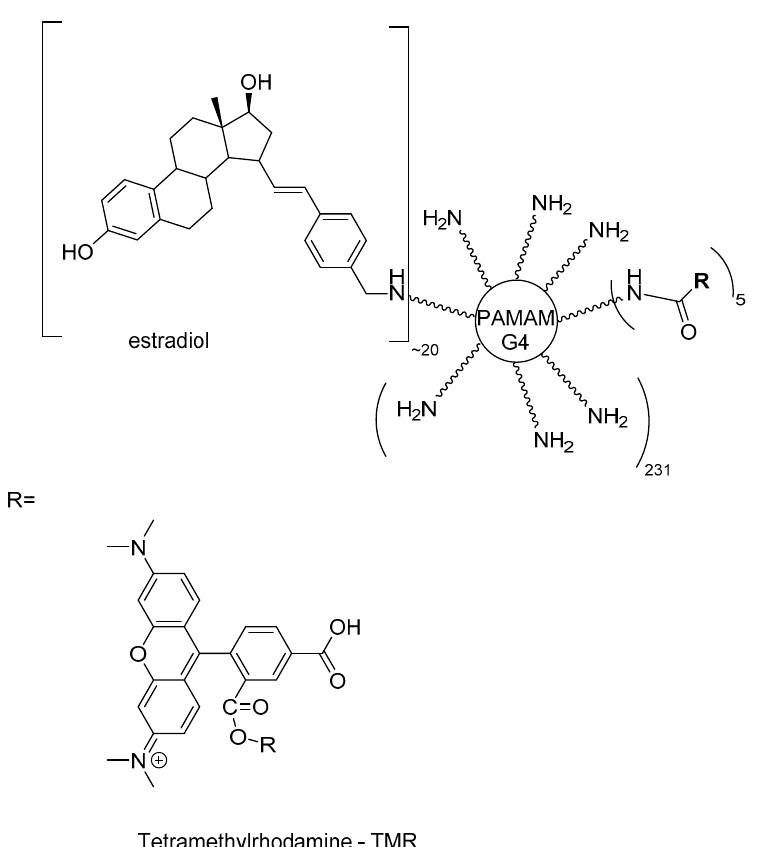
Figure 17. A PAMAM dendrimer conjugated to estradiol [151].